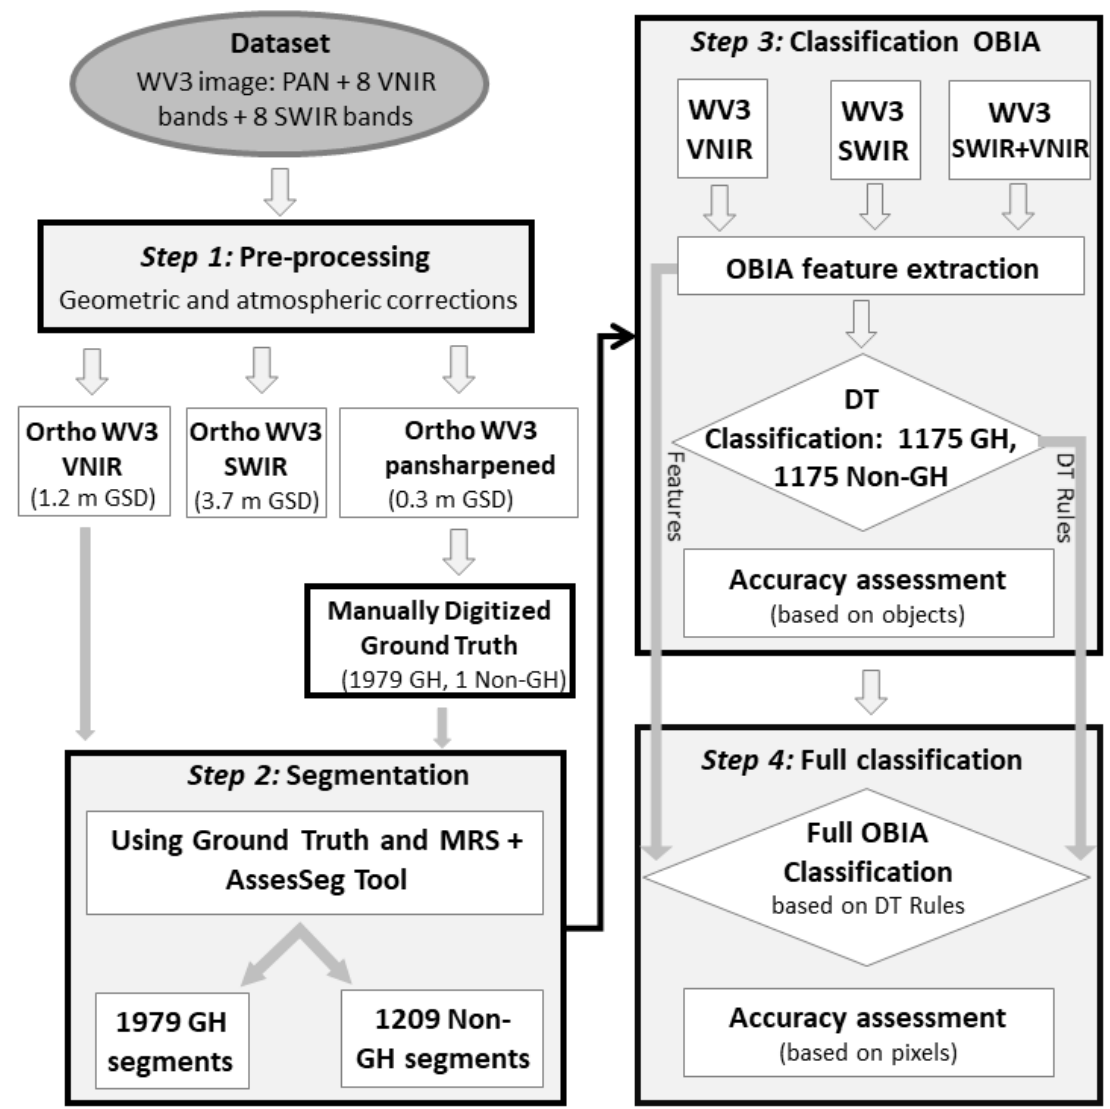
Figure 2. Flowchart of the methodology proposed in this work.